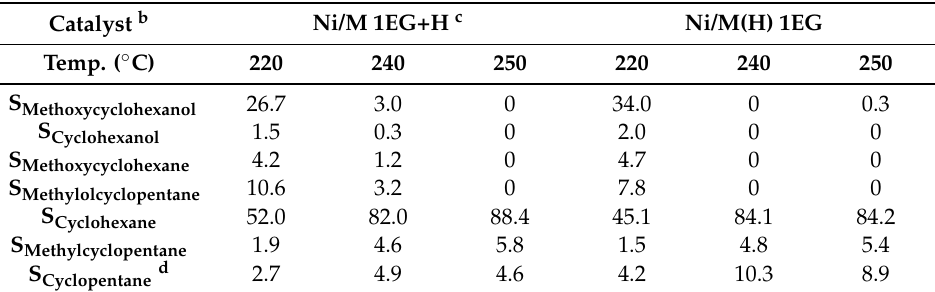
Table 5. Hydrodeoxygenation activity of guaiacol promoted by HZSM-5 under high temperature a . Catalyst